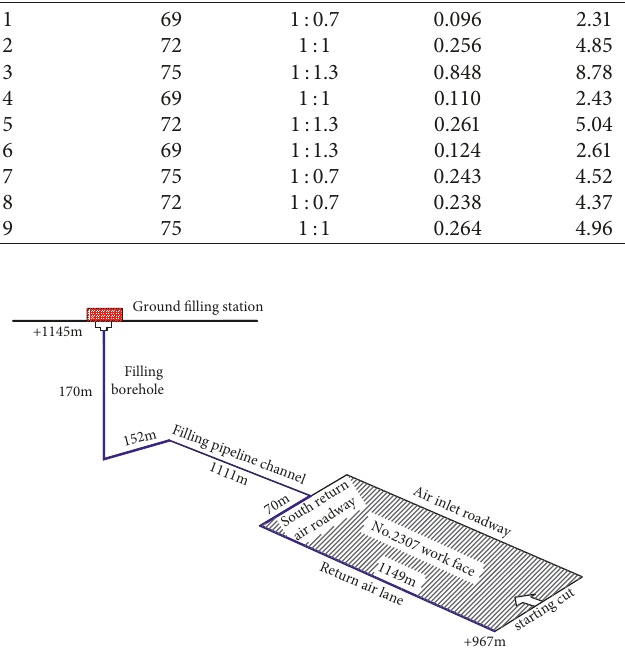
Figure 4: The backfill pipeline route from filling station to no. 2307 work